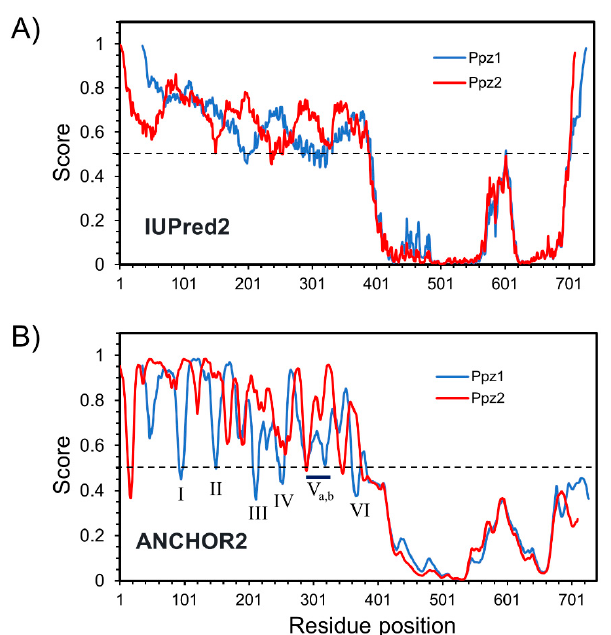
Figure 7. Prediction of intrinsically disordered regions (IDRs) and folding upon binding regions for Ppz1 and Ppz2. ( A ) Prediction of IDRs according the IUPred2 software. Note that the Ppz1 sequence has been shifted 35 residues to allow for the overlapping of the catalytic domain’s profiles. ( B ) Prediction of disordered binding regions according the Anchor2 software. The annotated peaks in Ppz1 (I to VI) are discussed in the text. The 0.5 cut-off (discontinuous line) corresponds to a 5% false positive prediction on IDRs or ordered protein segments.